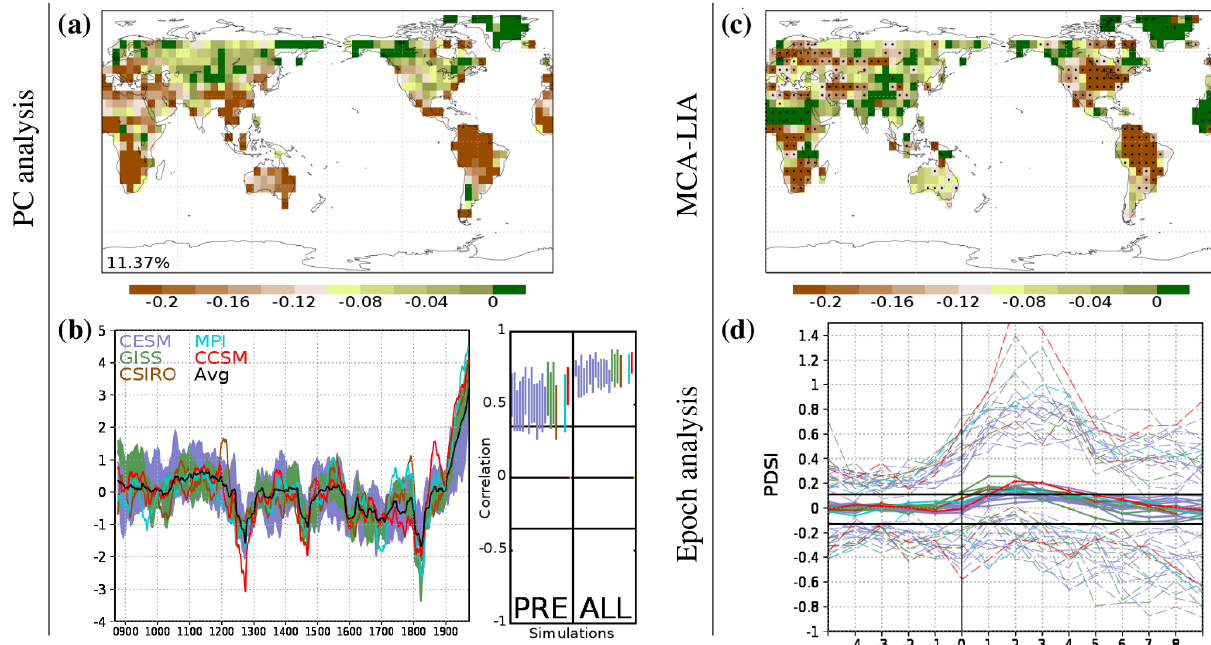
Figure 16. Analysis of scPDSI for the ensemble of simulations included in Table 1. (a) First EOF and (b) first PC time series for each simulation, as well as the average PC of all the simulations (black line). The percentage of explained variance is shown within the EOF map. The range of correlations between the PC of each simulation and those of other simulations is also included on the right of the plotted PCs both for the whole period (ALL) and for the preindustrial era (PRE). For these correlations, the significance level ( p < 0 . 05) accounting for autocorrelation is shown with a black line. (c) Map of scPDSI differences between MCA and LIA. Dots indicate locations where the differences are significant ( p < 0 . 05). (d) Composite average (solid lines) and maximum and minimum (dashed lines) global scPDSI anomalies in the 5 years before and 10 years after the 12 main volcanic eruptions of the LM. The vertical line indicates the year of the volcanic event. The horizontal black lines show the significance level of the average ( p < 0 . 10) based on the distribution of averages of 12 years generated with 2200 sets randomly taken from the whole period excluding the years of the 12 main volcanic eruptions and the 10 years after